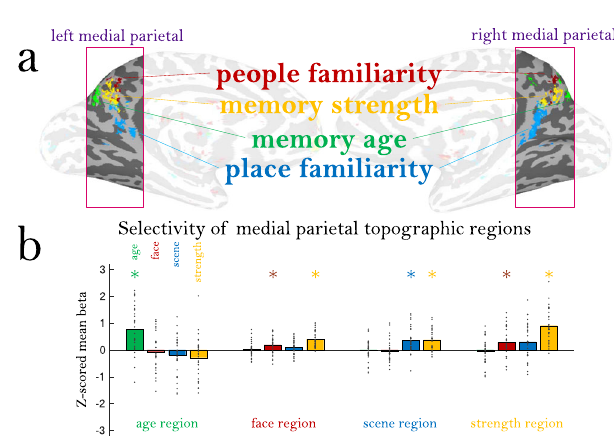
Fig. 8 | Distribution of memory content in the medial parietal cortex. a The medial parietal cortex (mPC) contains a topographic map representing different typesofmemoryinformation.Shownherearethetop1000voxelswithsignalfor four different types of information: memory age, people familiarity, place familiarity, and memory strength. Each map is shown at 50% transparency; if a voxelissharedacrossmultiplecontenttypes,itwillbecoloredbybothmaps(i.e., a “ winner ” is not determined in any given voxel). Notethe low amount of overlap across content types and hemispheric symmetry of these maps. b Results of a leave-one-out analysis of the mean beta for each content type in each of the topographic regions. Topographic regions were localized with all but one parti- cipant,andthenthemeanz-scoredbetaoftheleft-outparticipantisplotted(each dot). Bars show the mean beta across participants, and * indicate a signi fi cant difference in a two-tailed t-test versus 0 (FDR corrected across all comparisons, q <0.05); exact statistics are reported in the main text. Source data are provided in the Source Data fi